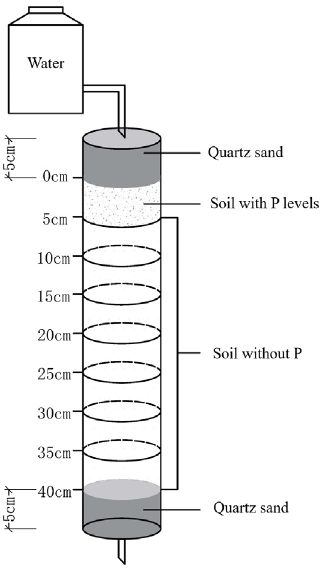
Figure 2. Schematic diagram of soil column.